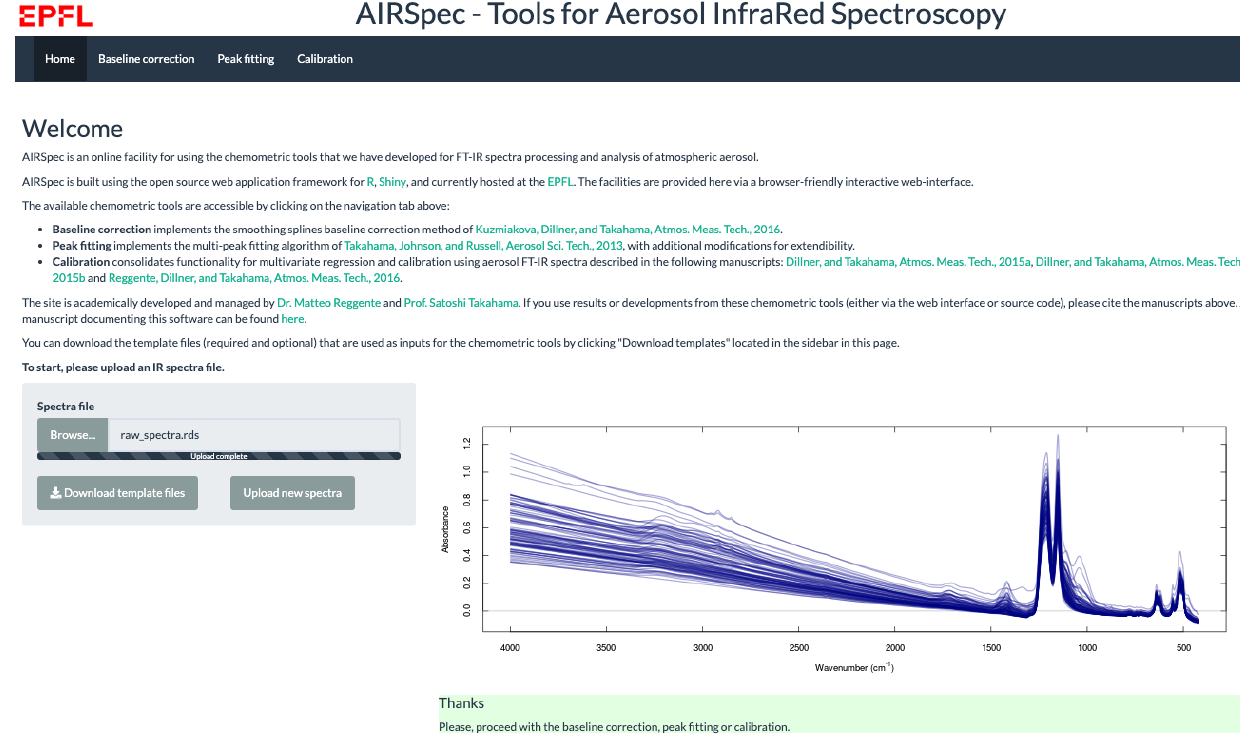
Figure 2. AIRSpec home page. Table 1. List of inputs for each chemometric package.